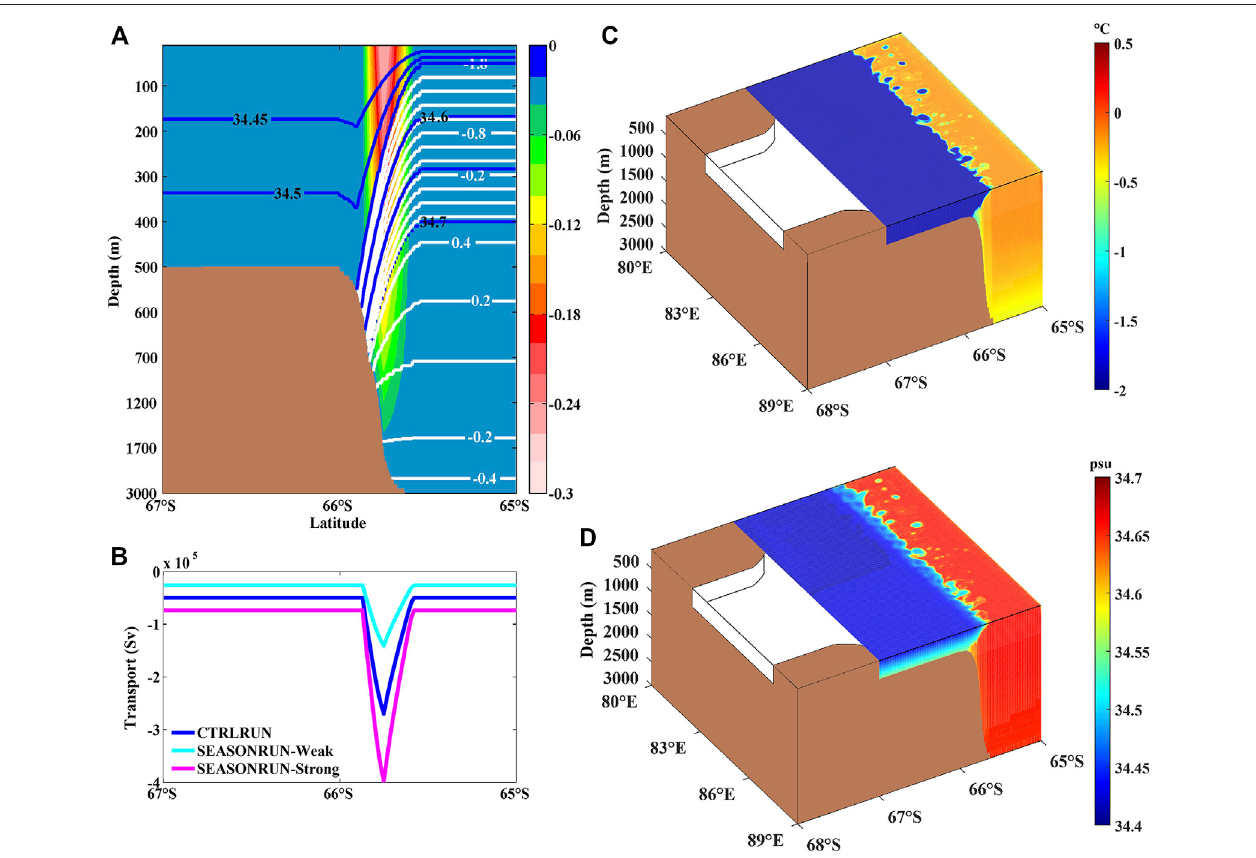
FIGURE 2 | (A) The cross-section of the zonal open boundary conditions in the CTRLRUN. The color shading is the zonal velocity (negative westward/into the page);whitelinesarethepotentialtemperature ( ° C)incontourintervalsof0.2 ° C;bluelinesarethesalinity (psu)incontourintervalsof0.05. (B) Cross-shelfvariationofthe vertical integrated zonal transport (Sv). (C) A snapshot of the potential temperature ( ° C) in the CTRLRUN, the top layer is at 100 m depth. (D) Same as (C) , but for the salinity (psu).